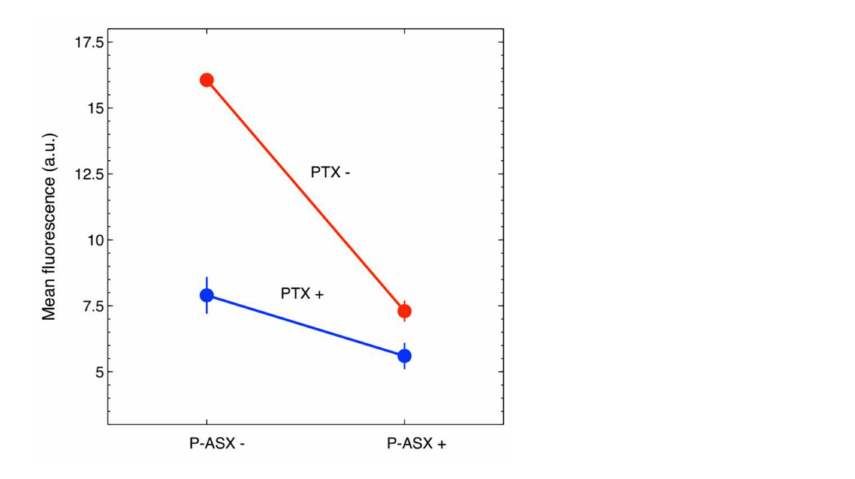
Figure 4. Graphical representation of the synergic effect of PTX and ASX microparticles on intracellu- lar ROS reduction in J774A.1 cells. The two lines would be expected to be parallel if there were no synergic effects [15]. Formally, synergism is demonstrated by two-ways ANOVA statistical analysis (see Table 1).